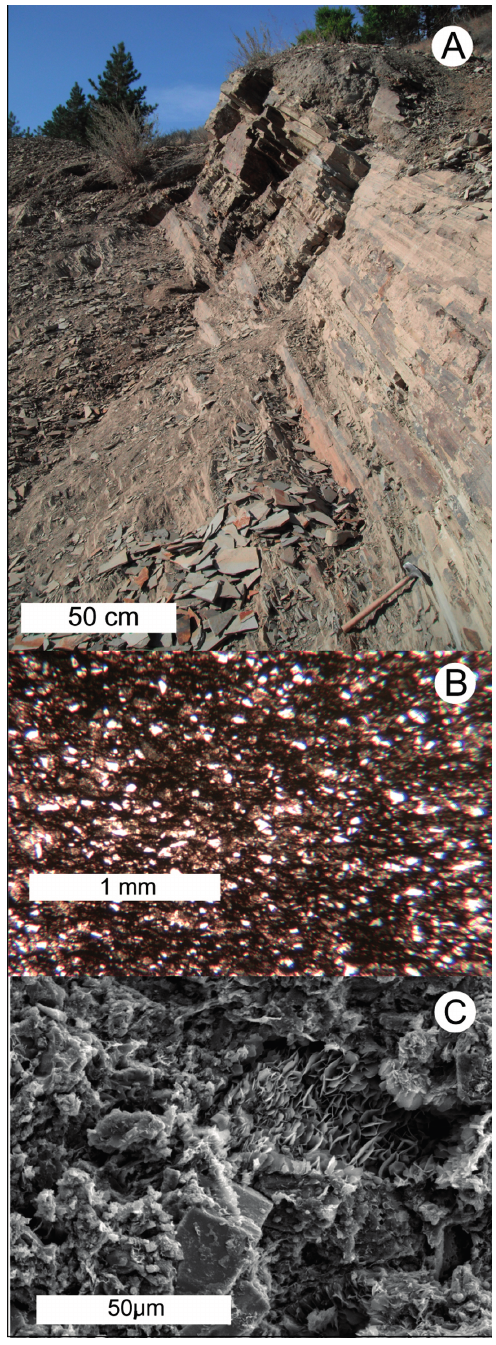
Figure 9. Middle laminated mudstone unit: ( A ) outcrop view; ( B ) thin section view under polarized light; and ( C ) SEM photomicrograph (specimen WWU SR-7). Blocky grains are relict phenocrysts from volcaniclastic debris; diagenetic clay minerals are visible as a crinkly zone in the right central area of the